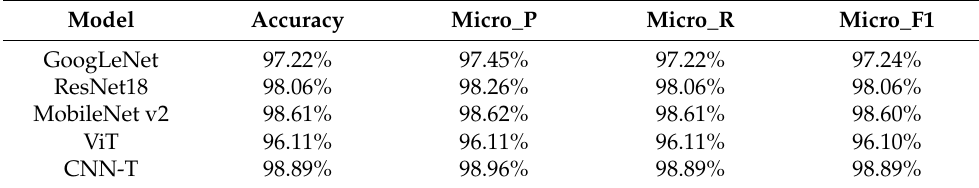
Table 2. Accuracy, precision, recall, and F1 of different models when the training ratio is 75%.